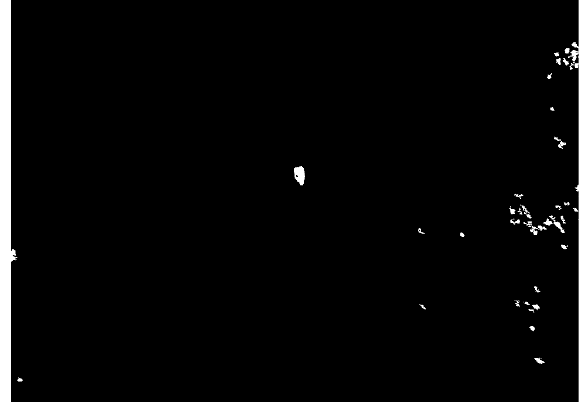
Figure 5. Post classification result (connected region area threshold: 100 pixels).